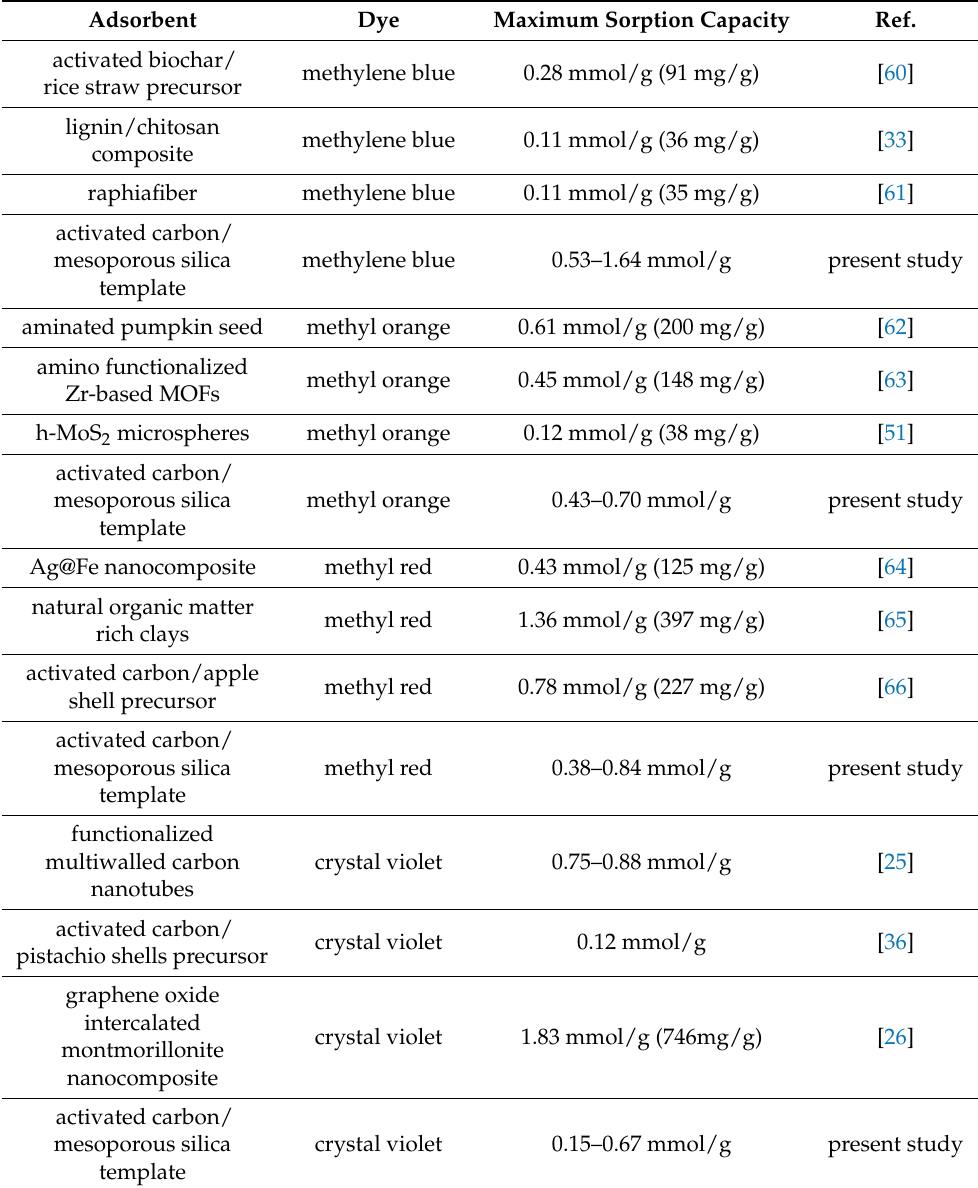
Table 4. Comparison of the maximum adsorption capacity of different adsorbents towards the studied